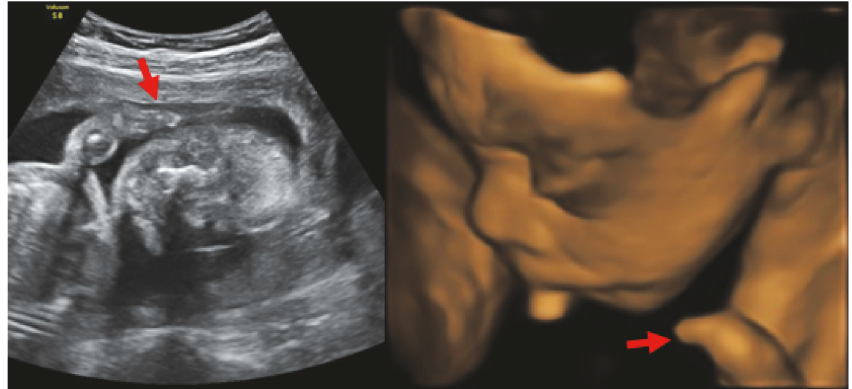
Figure 1: Two-dimensional (right) and three-dimensional (left) prenatal ultrasound images showing short forearms of 7 mm and 9 mm (arrows) and short humeri and femurs (–2.1 standard deviation, SD).